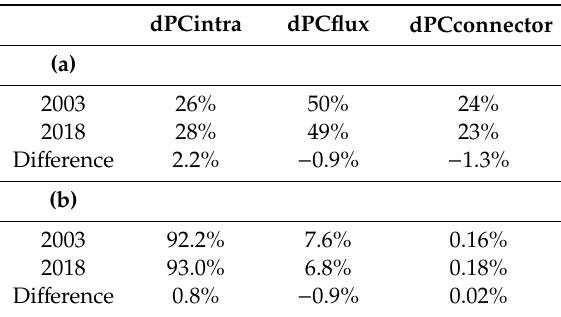
Table 7. Change in percent contribution of component parts of the PC index between 2003 and 2018 for (a) crested tit habitat networks and (b) common toad habitat